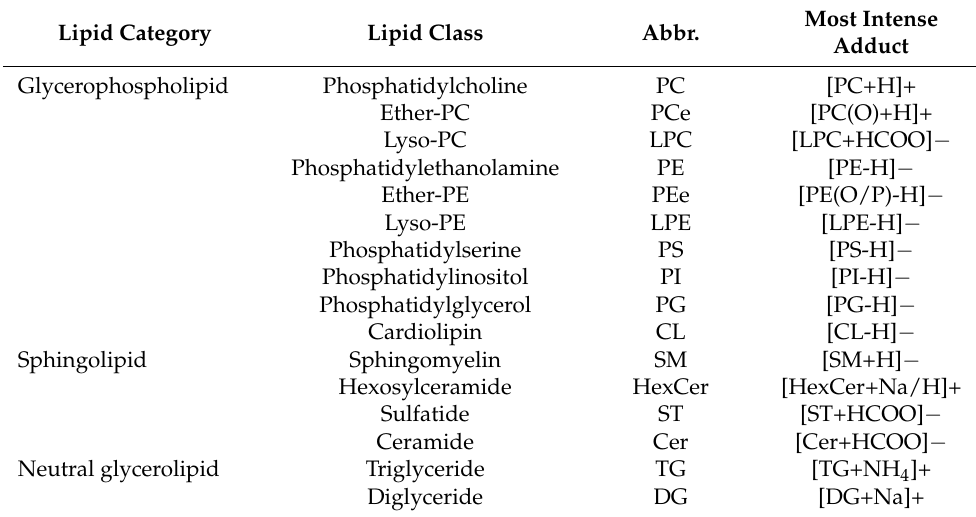
Table 1. Lipid classes detected by UHPLC-MS after lipid extraction from PBS and Trizol homogenates of kidney. Abbreviations (Abbr.) and the adduct of the highest intensity are indicated for each lipid